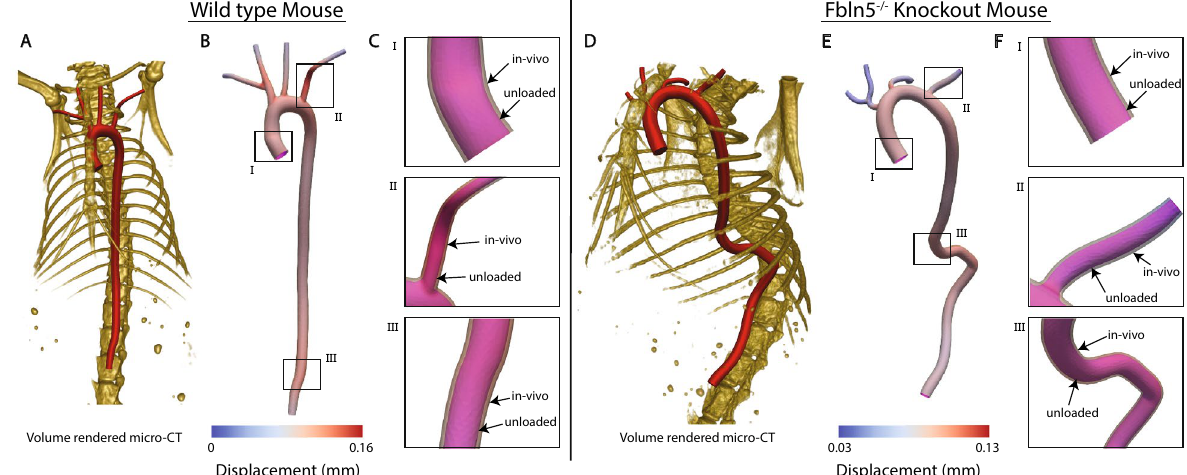
Figure 7. ( A ) Volume rendered geometric model of the aortic anatomy of a 20 weeks old wild type female mice. ( B ) Plots of the predicted unloaded configuration overlaid upon the medically imaged in vivo anatomy. ( C ) Enlarged version of unloaded and in vivo configurations at three different locations indicated in ( B ). ( D ) Volume rendered geometric model of the aortic anatomy of a Fbln 5 − / − knockout male mice. ( E ) Plots of the predicted unloaded configuration overlaid upon the medically imaged in vivo anatomy. ( F ) Enlarged version of unloaded and in vivo configurations at three different locations indicated in ( E